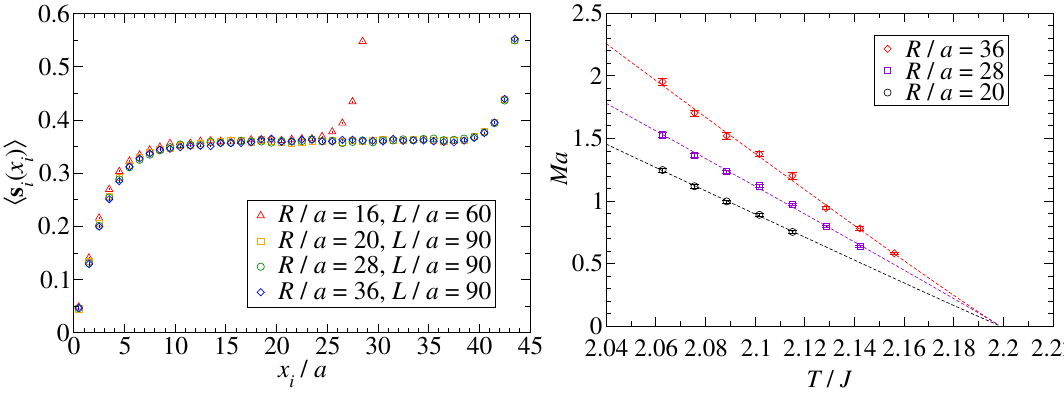
Figure 4 . Left-hand-side panel: dependence of the spin profile h s i ( x i ) i on the spatial coordinate x i /a , as measured with respect to the center of the system, at a fixed temperature and for different values of the Euclidean-time extent of the lattice. All results shown in this plot were obtained from simulations with T/J = 2 . 062725 . Right-hand-side panel: temperature dependence of the Ma parameter, extracted from the fits of our numerical data to eq. (3.3), for lattices with different values of R/a , and their fits to eq.